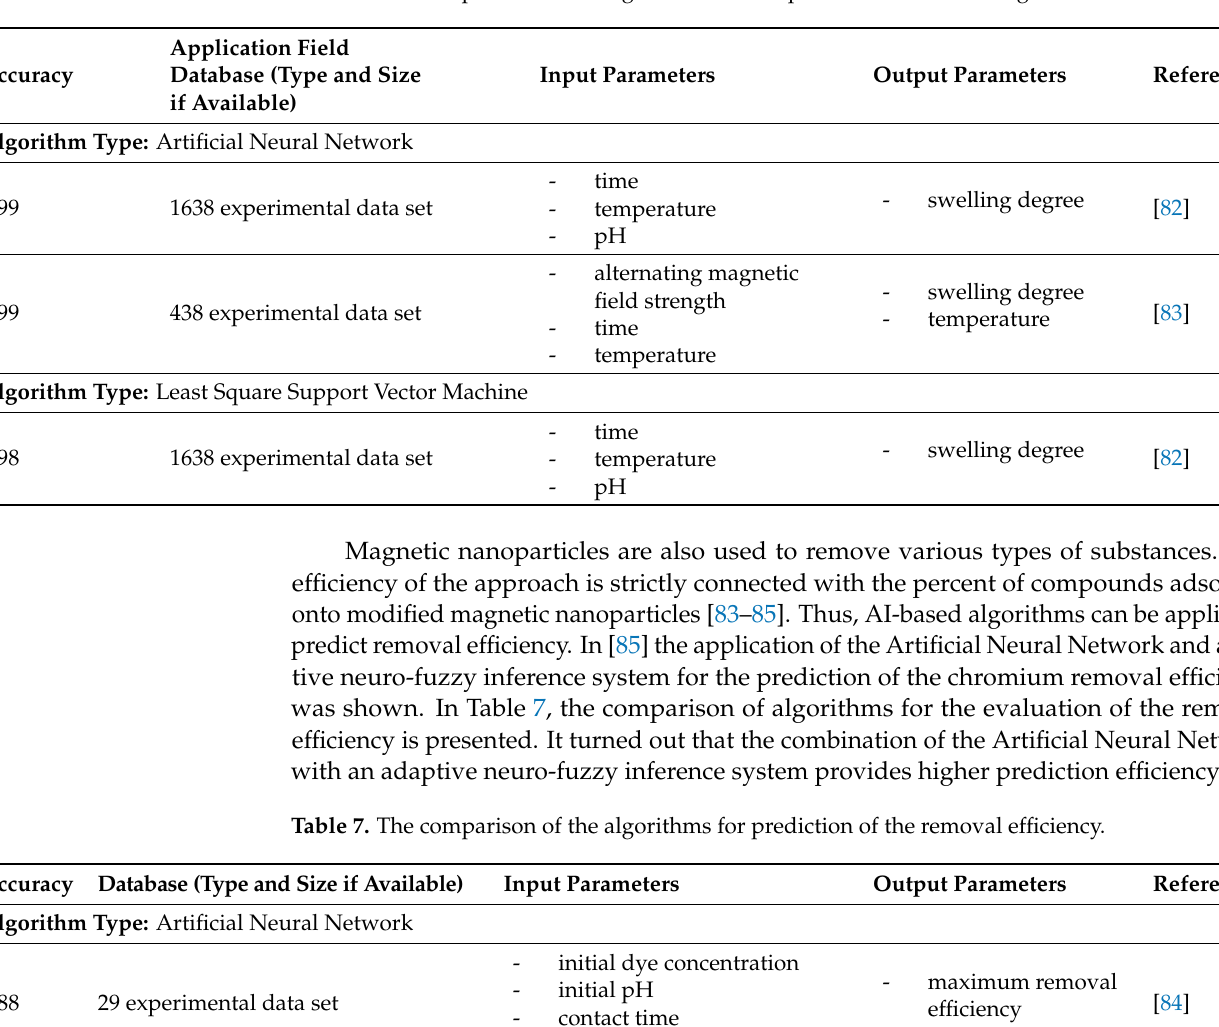
Table 6. The comparison of the algorithms for the prediction of deswelling behavior.